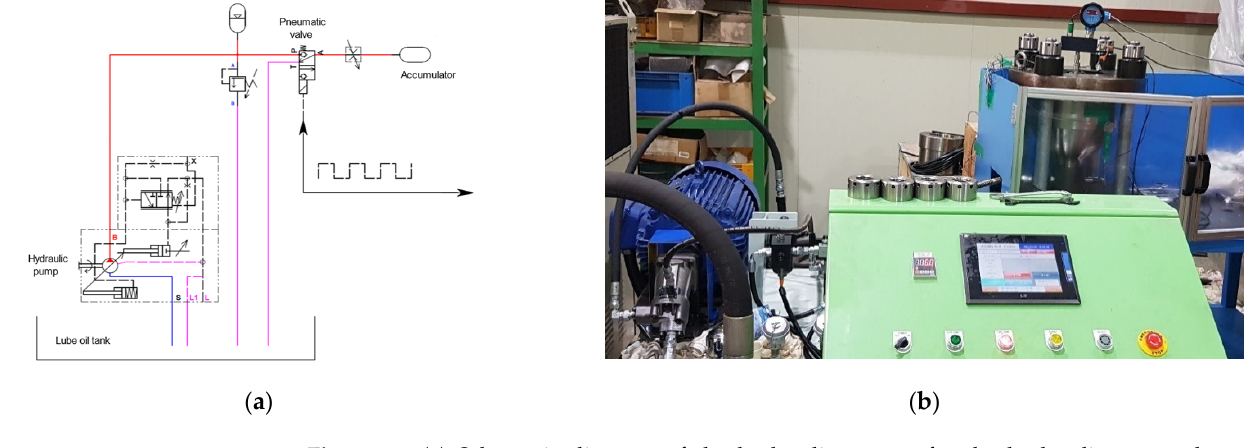
Figure 2. ( a ) Schematic diagram of the hydraulic system for the hydraulic accumulator test; ( b ) experimental setup for testing the hydraulic accumulator.